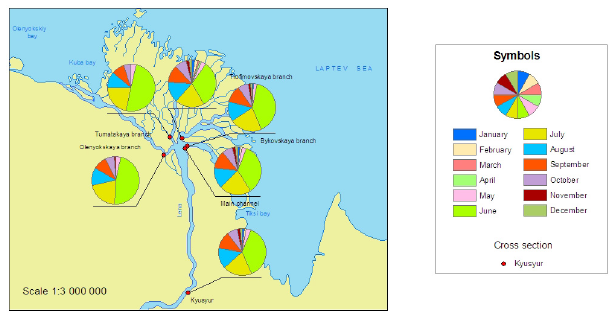
Figure 4. Intra-annual distribution of average annual suspended sediment supply in the Lena River